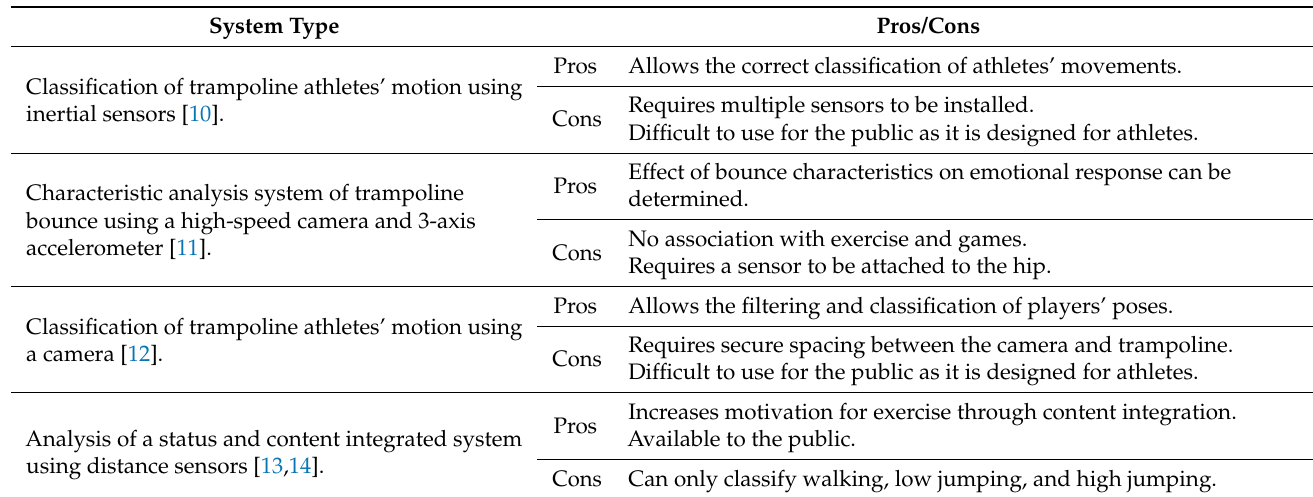
Table 1. Pros and cons of a trampoline system using